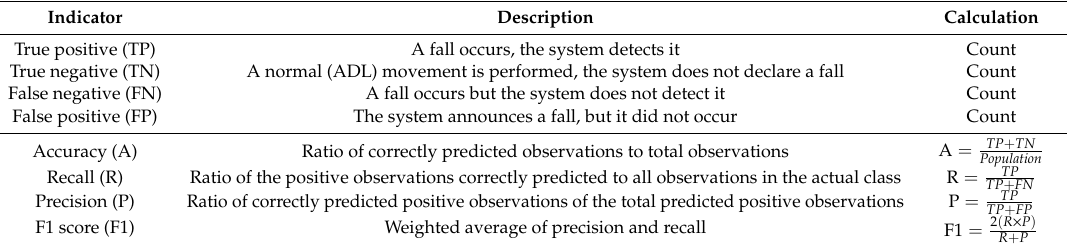
Table 3. Explanation of indicators for algorithm performance